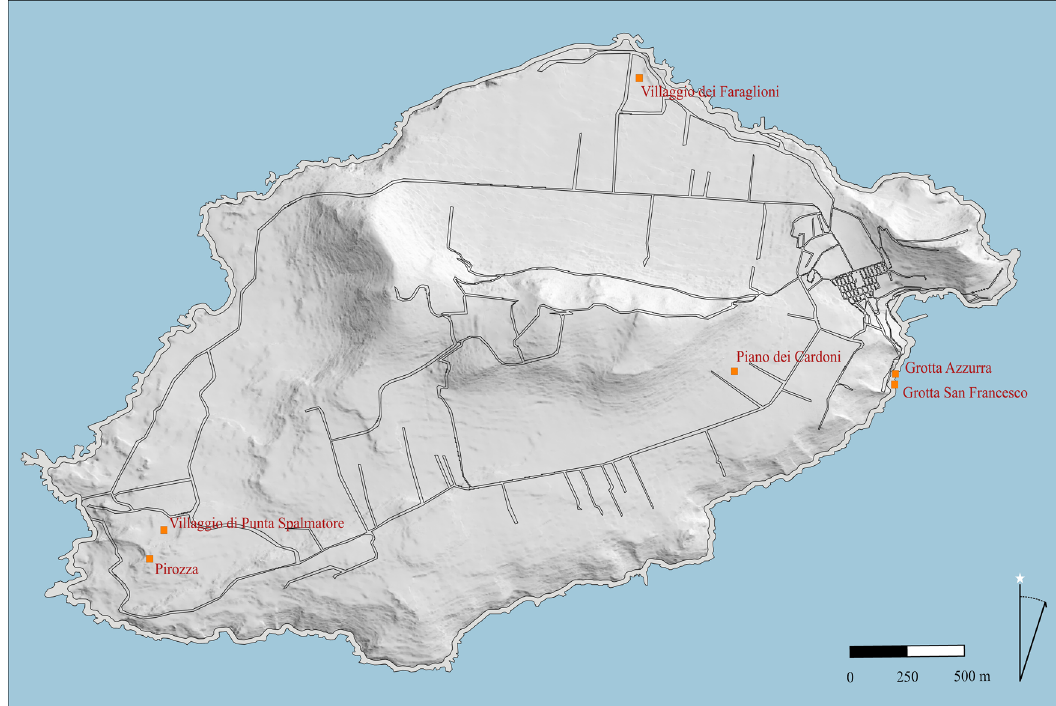
Figure 3: Name of the archaeological sites cited in the